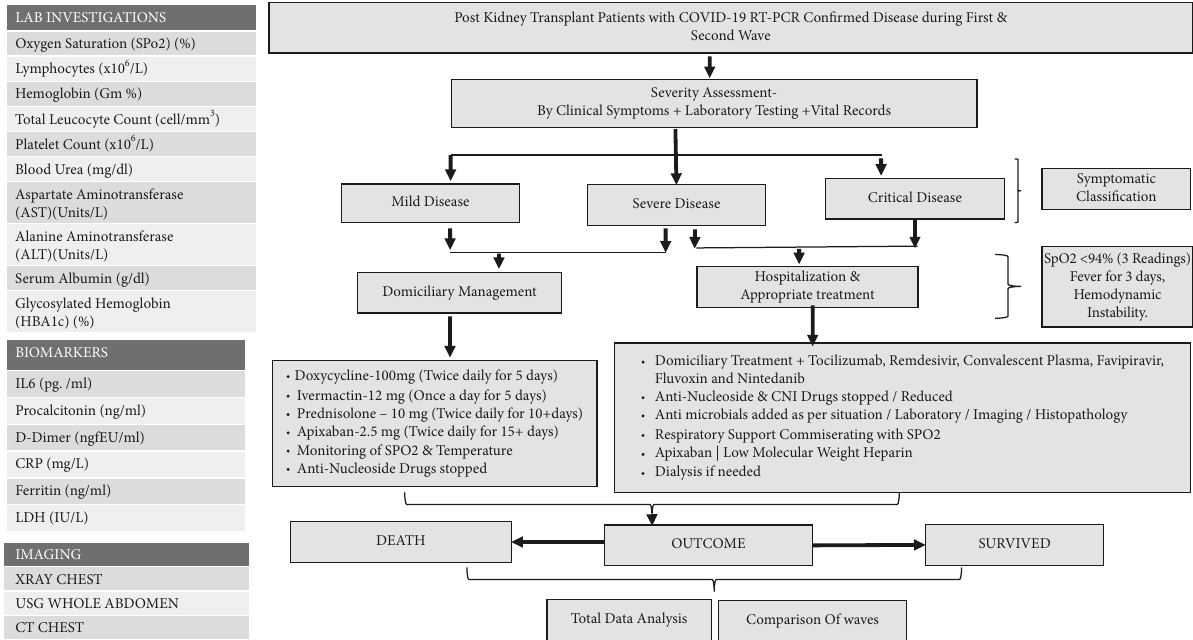
Figure 1: Schematic representation of clinical presentation, laboratory assessment, treatment options, and outcomes during the two waves of COVID-19 disease affecting kidney transplant